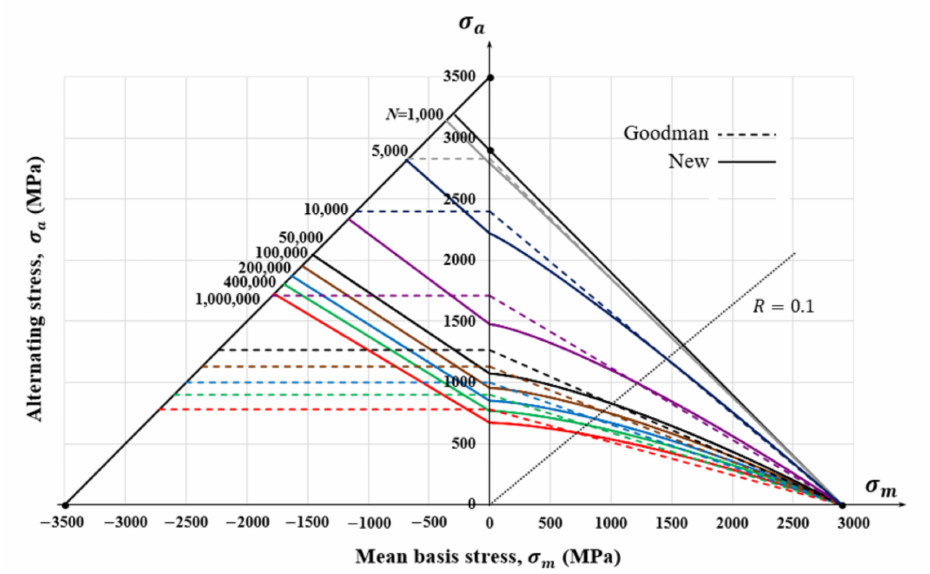
Figure 13. Goodman–Haigh diagram (dashed lines) and the presented MSCD (solid lines for the case of ζ 1 = 1.5, ζ 2 = 1.0 and F c 1 = 2.65).